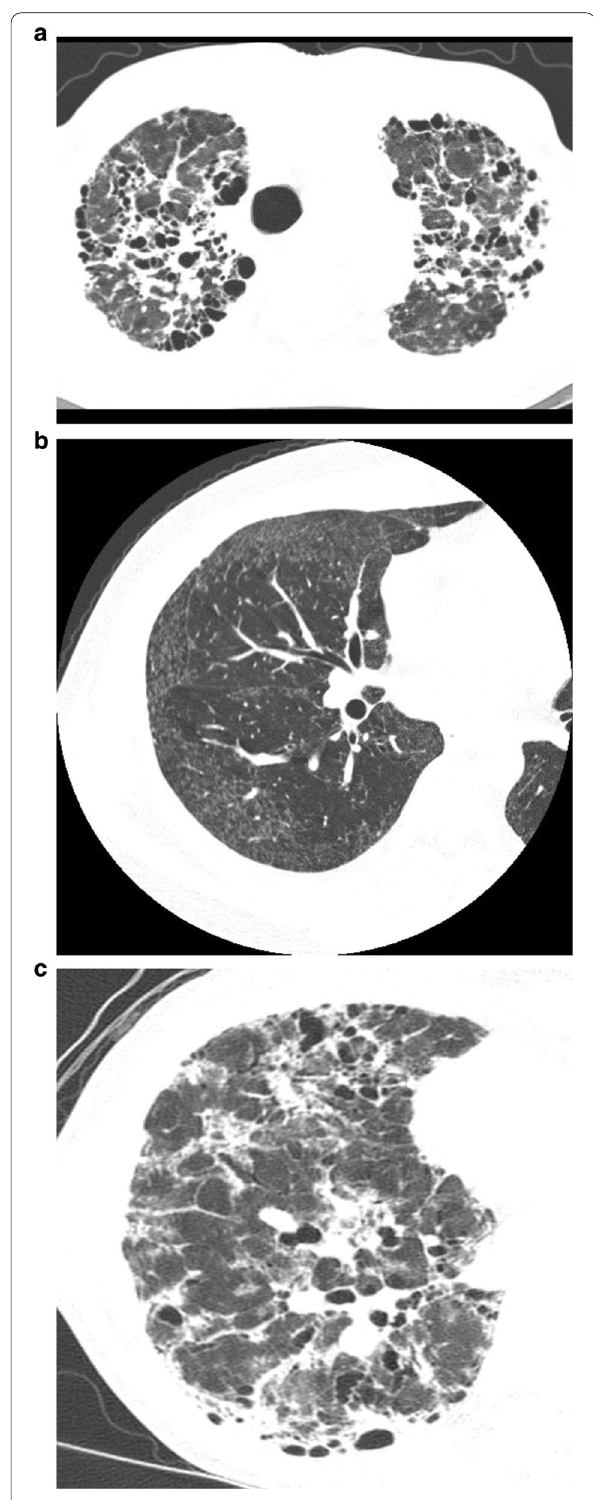
Fig. 5 HRCT scans of heard metal pneumoconiosis. a 62-year-old man with hard metal pneumoconiosis. Upper-lung predominant fibrosis in hard metal pneumoconiosis. HRCT scan shows prominent interstitial thickening, irregular peribronchovascular thickening, and traction bronchiectasis in upper lung zones. b 32-year-old man with hard metal pneumoconiosis. Early stage of hard metal pneumoconiosis. HRCT scan shows ground-glass opacities and centrilobular nodules predominantly in the peripheral portions. c 53-year-old man with hard metal pneumoconiosis. HRCT scan shows patchy and irregular ground-glass opacity and traction bronchiectasis diffusely distributed in the lung. Bullae are seen in the subpleural region.